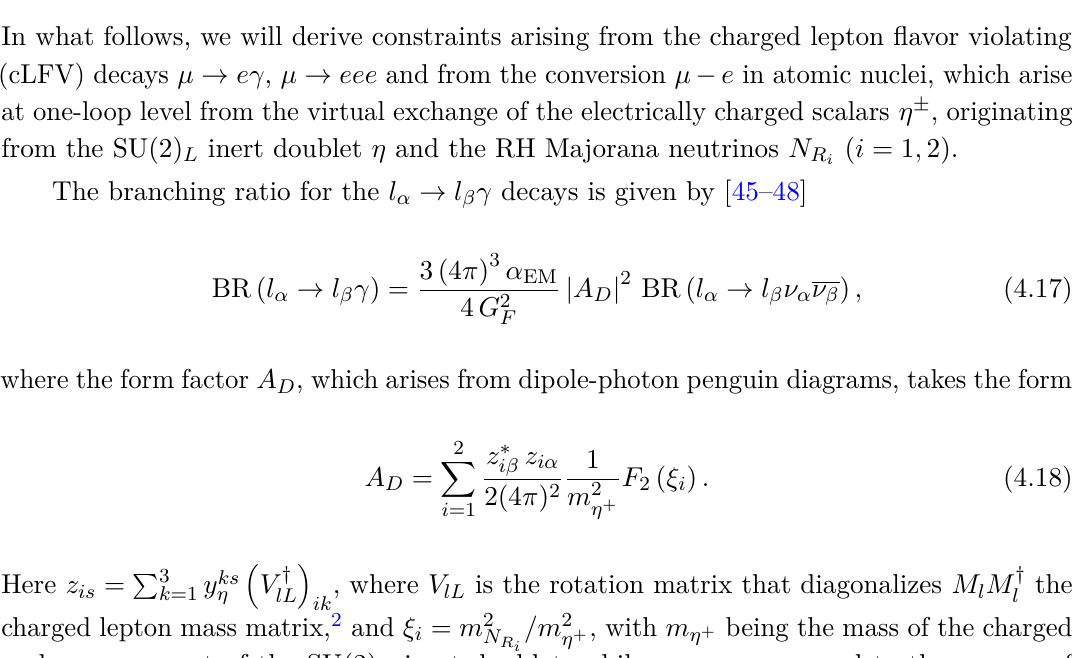
Figure 2 . The 1 - σ and 2 - σ regions in the m Φ oblique S , T and U parameters including the CDF measurement of the W mass. In the left (right) panel the mass of the neutral scalar Φ 2 is m Φ angle is fixed at θ Φ = 0 . 2